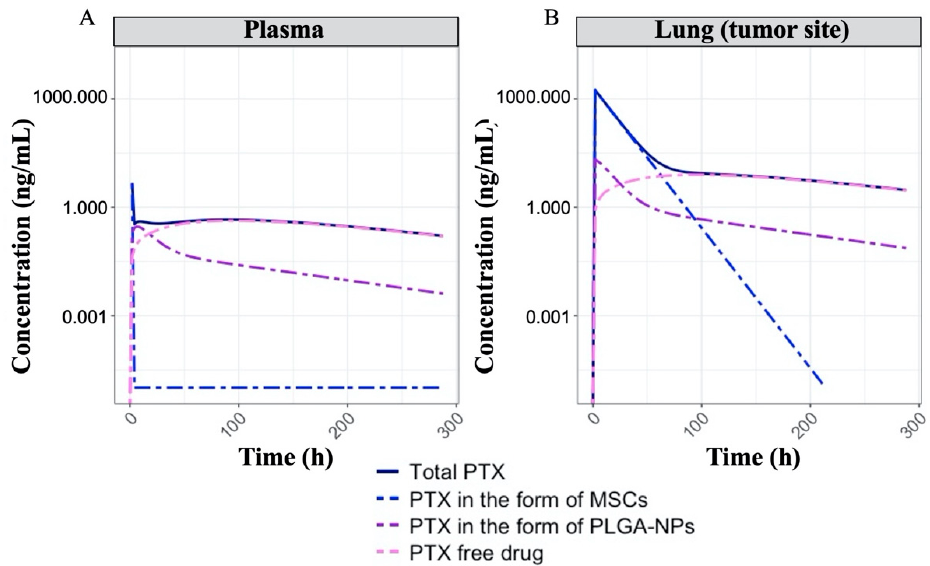
Figure 7. Simulated PTX concentration–time profiles in plasma ( A ) and tumor-bearing lungs ( B ) following a single IV dose of nano-MSCs administration. The plots are on log scales. On both plots, the dark-blue solid lines represent the total PTX concentrations in the respective tissues. The blue, purple and pink dash–dot lines represent the PTX concentrations in the forms of MSCs, PLGA NPs and free drug, respectively.